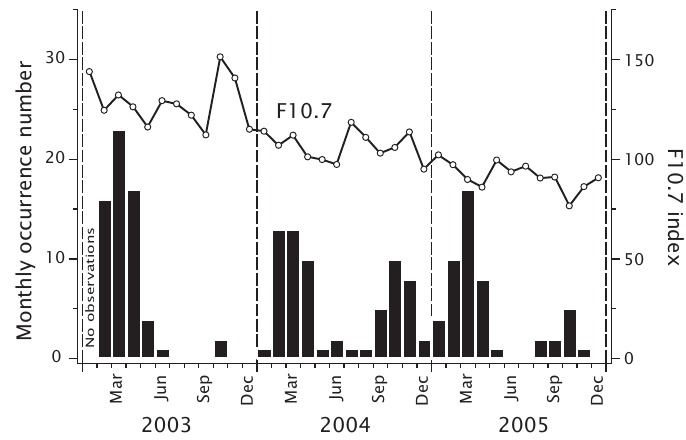
Fig. 10. Monthly occurrence of satellite trace and F10.7 solar flux